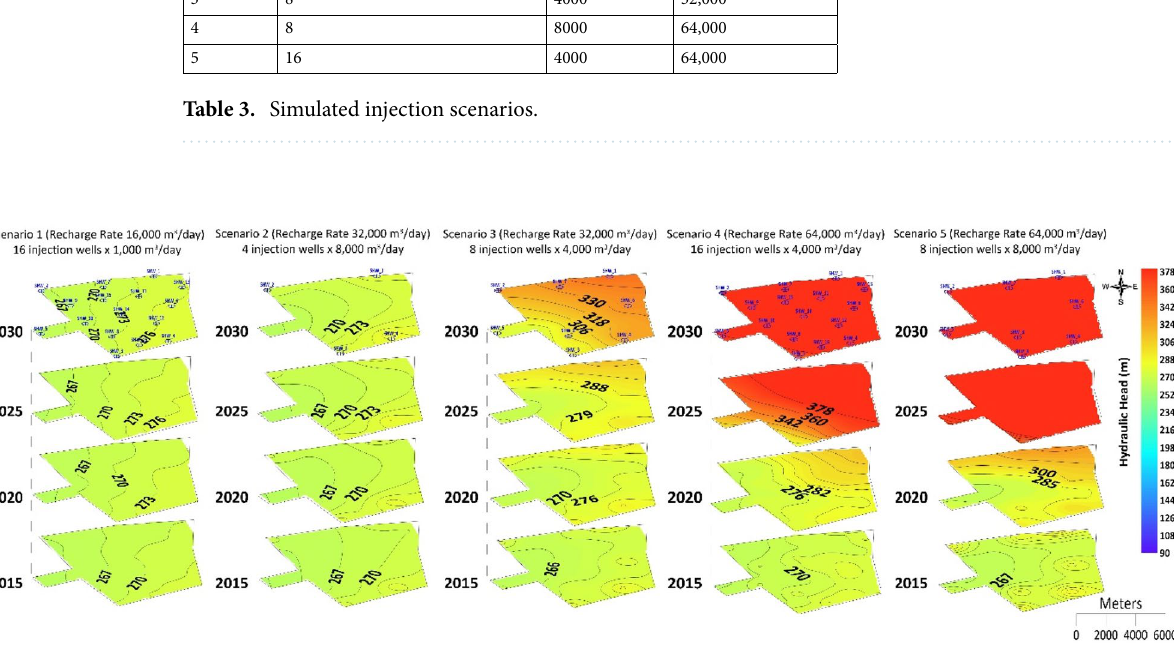
Figure 5. Simulated hydraulic heads at Al-Shuwaib site for the five recharge